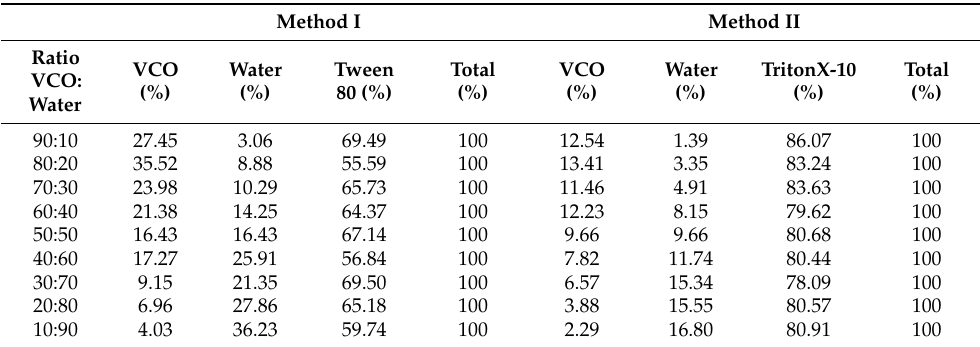
Table 1. Ratios of VCO, water, and surfactants (Tween 80—Method I and TritonX-100—Method II) to develop a ternary phase diagram and produce a stable VCO